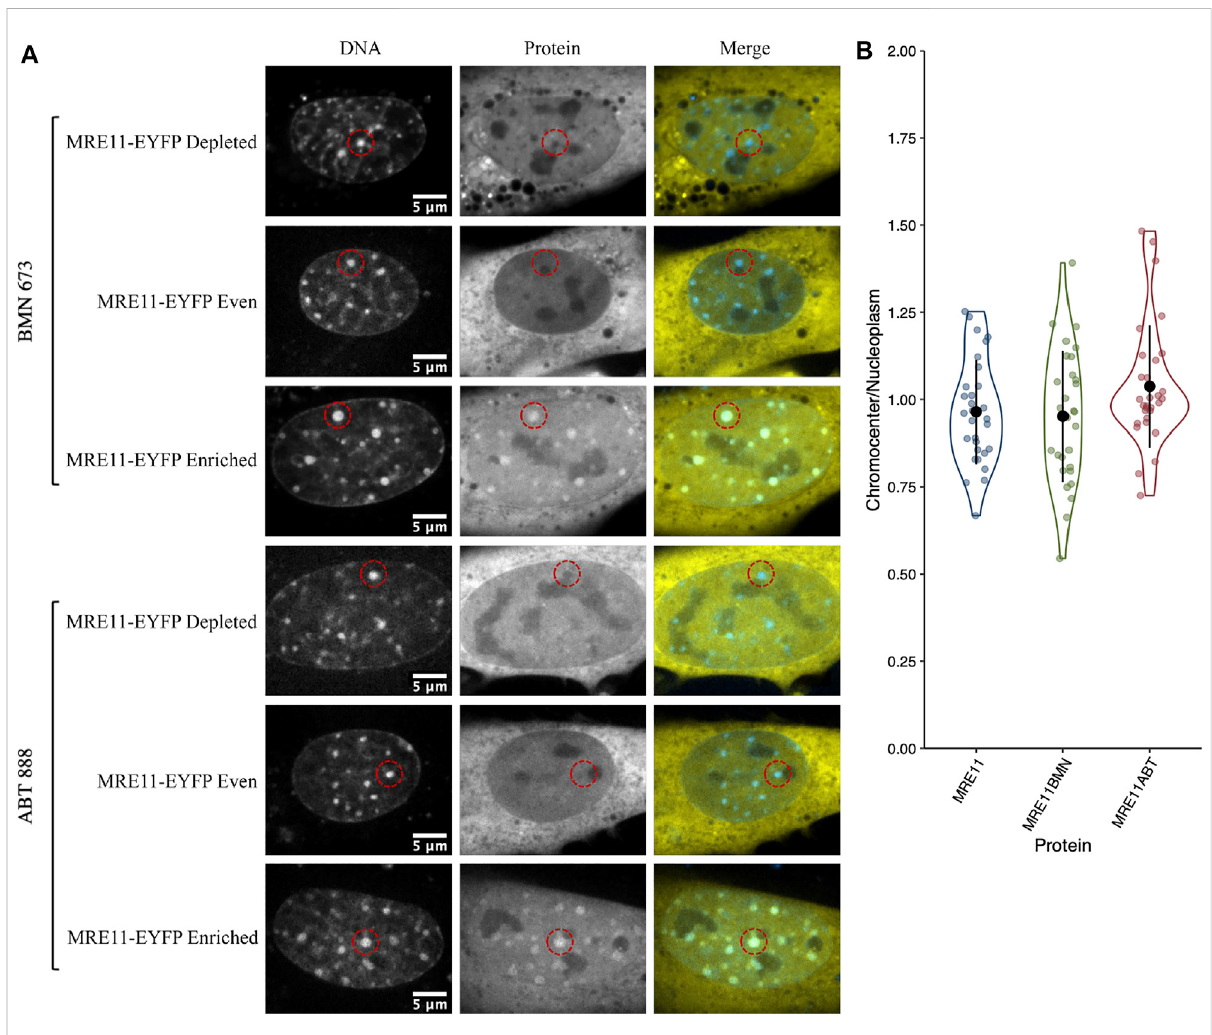
FIGURE 2 MRE11-YFP chromocenter heterogeneity is not dependent on poly (ADP-ribosyl)ation (A) CH3/10T1/2 cells were transfected with MRE11-YFP, Hoechst33342wasaddedtovisualizeDNA,andthenincubatedwitheitherBMN673orABT888ataconcentrationof10 µMfor1 hbeforeimaging. An example of depleted, homogenous, and enriched distributions are provided for both inhibitor groups (B) Graph shows quanti fi cation of relative chromocenterintensityforeachgroup.MRE11-YFPcontrolisincludedfordirectcomparison.Eachproteinhas n =30.MRE11-YFPcontrolisnot signi fi cantly different from either MRE11-YFP treated with BMN 673 ( p = 0.77) or MRE11-YFP treated with ABT 888 ( p =